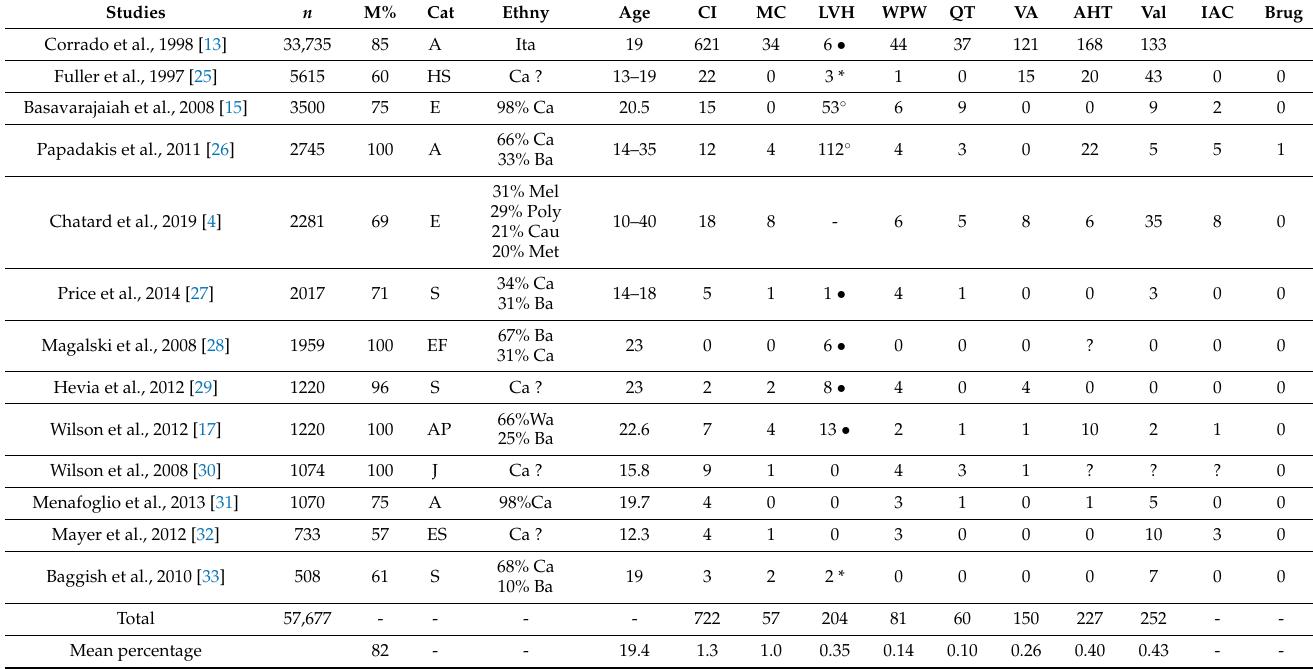
Table 4. Number of cardiac diseases found after athlete screening in 13 studies. M: male, Cat: athlete category, CI: contra- indication to sports, MC: myocardiopathy, LVH: left ventricular hypertrophy, WPW: Wolff–Parkinson–White, QT: long QTc, VA: ventricular arrhythmia, AHT: arterial hypertension, Val: valvulopathy, IAC: interatrial communication, Brug: